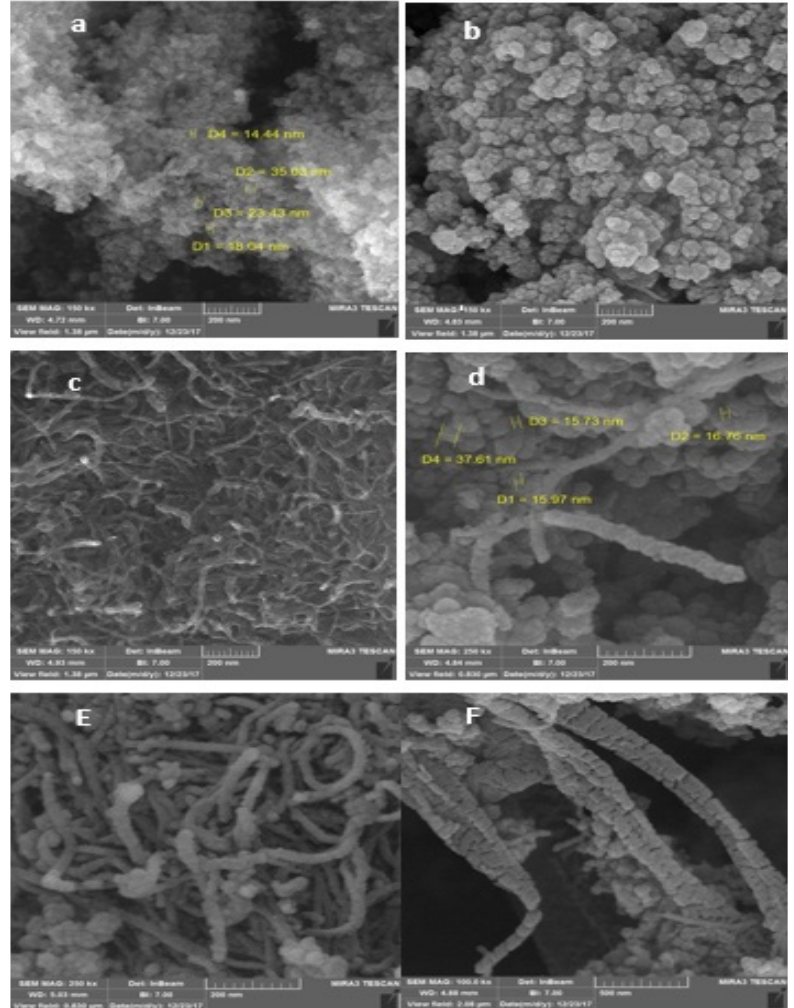
Fig. 8. FESEM images a) Fe